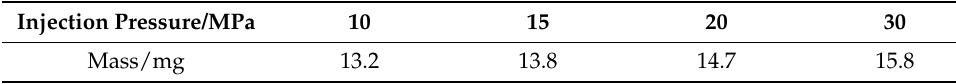
Table 3. Total mass of RP-3 kerosene per